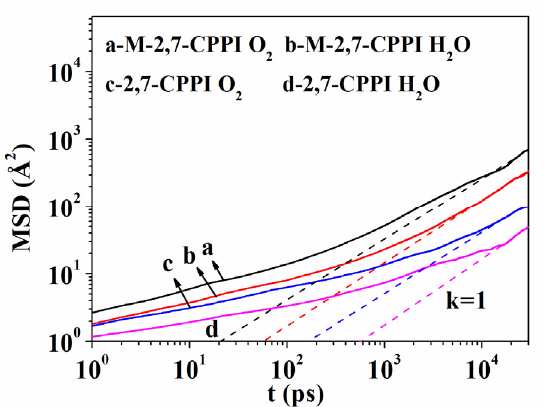
Figure 11. MSD of O 2 and H 2 O in M-2,7-CPPI and 2,7-CPPI as a function of time. Table 5. Simulated diffusion coefficients, solubility coefficients and permeability for O 2 and H 2 O in M-2,7-CPPI and 2,7-CPPI. PIs